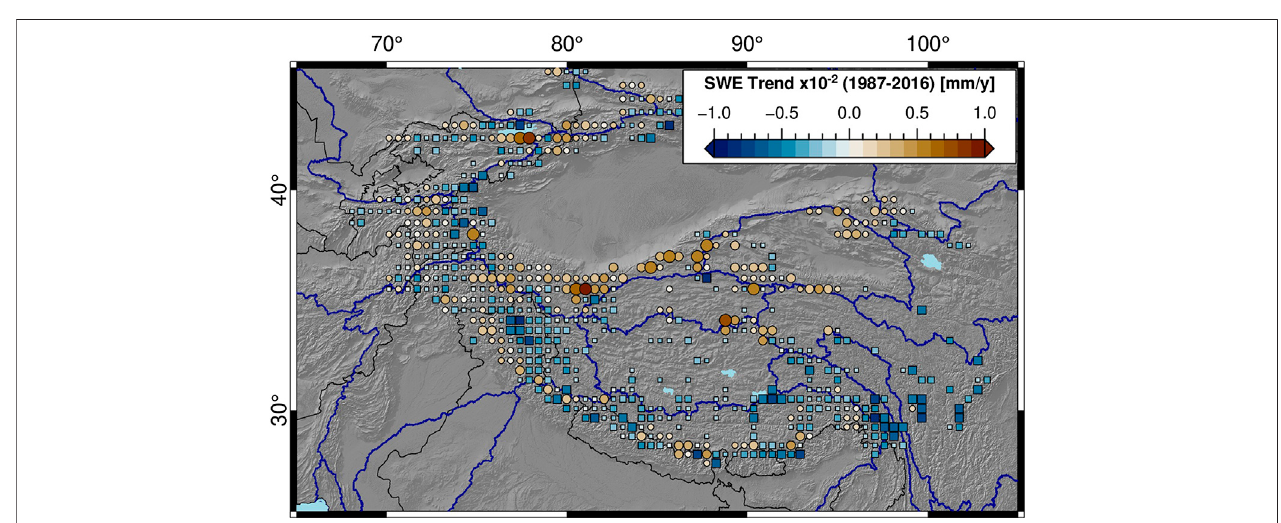
FIGURE 9 | Snow-water equivalent (SWE) trends and glacier areas aggregated into 50 km × 50 km boxes. Positive (negative) trends are symbolized as circles (squares), and sized logarithmically by total glacier area within each 50 km × 50 km aggregation window, from 1 to 1,500 km 2 . Blue outlines show major watersheds (Lehner and Grill, 2013). There are clear positive SWE trends over the heavily glaciated Karakoram-Kunlun Shan region, which are contrasted by negative SWE trends throughout much of the rest of High Mountain Asia.